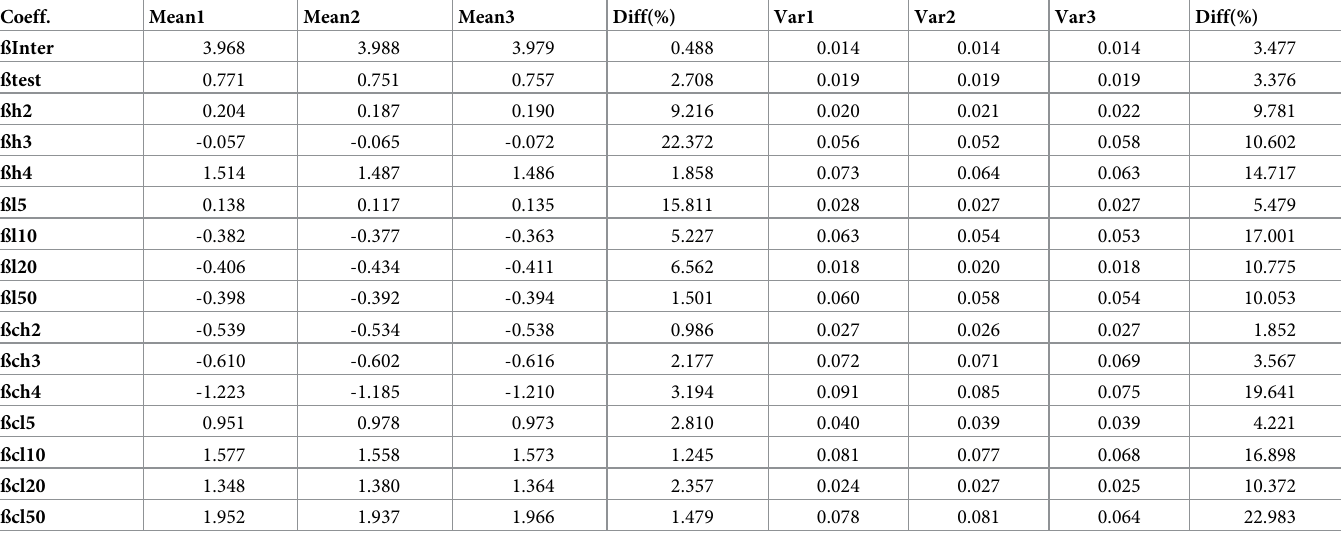
Table 4. Experiment 1. β coefficients